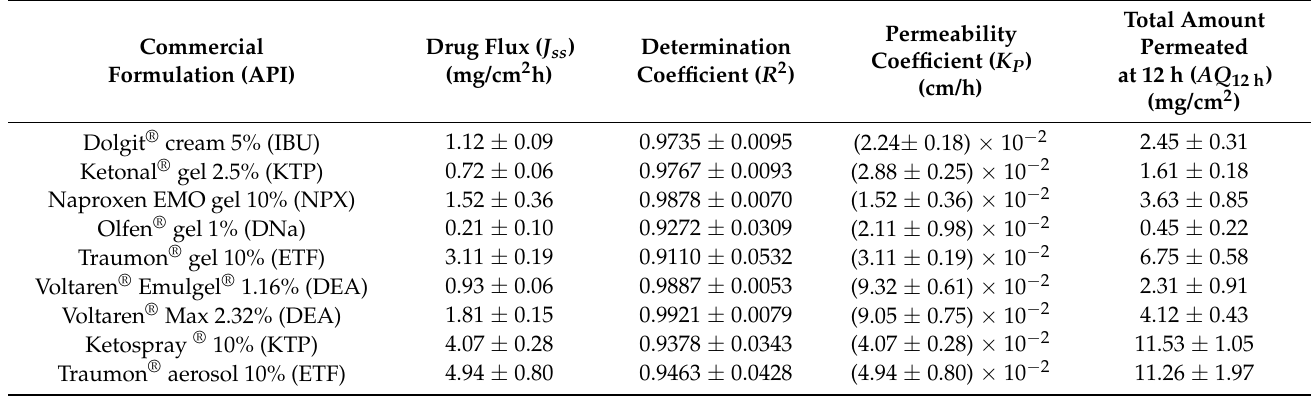
Table 4. NSAID permeation parameters from selected commercial formulations through Strat-M ® membrane in optimized in vitro test